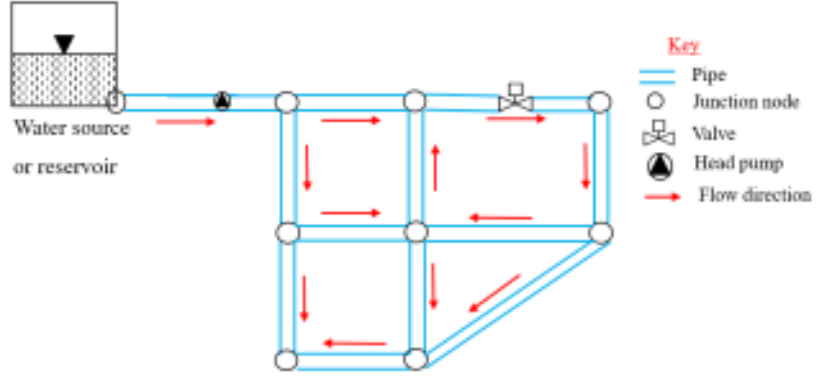
Figure 1. Basic water distribution network